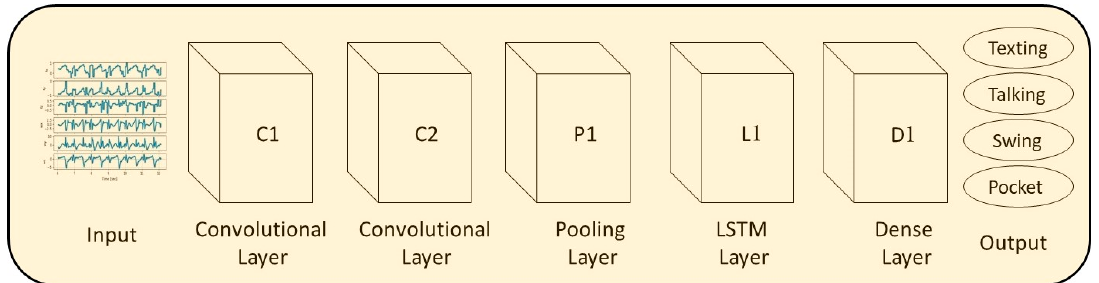
Figure 7. The CNN/LSTM network architecture used for the evaluation of SLR. Figure 7. The CNN / LSTM network architecture used for the evaluation of SLR.